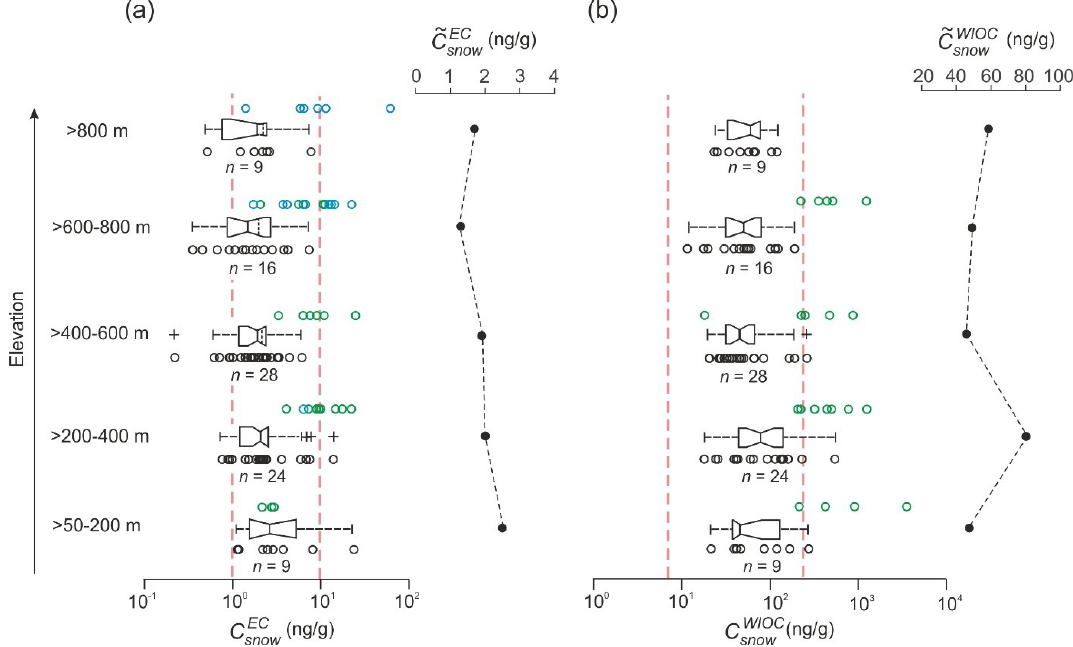
Figure 4. Measurements of (a) C EC snow and (b) C WIOC snow on Svalbard glaciers, grouped into discrete elevation bins. Data symbols and box plots are defined as in Fig. 3. Altitudinal profiles of the median values of C EC snow and C WIOC snow ( ˜ C EC snow , ˜ C WIOC snow ) are shown separately on linear scales. Note that the elevations on the latter plots are ordinal only, as ˜ C EC snow and ˜ C WIOC snow are computed from sample data collected at sites spanning a different range of altitudes within each